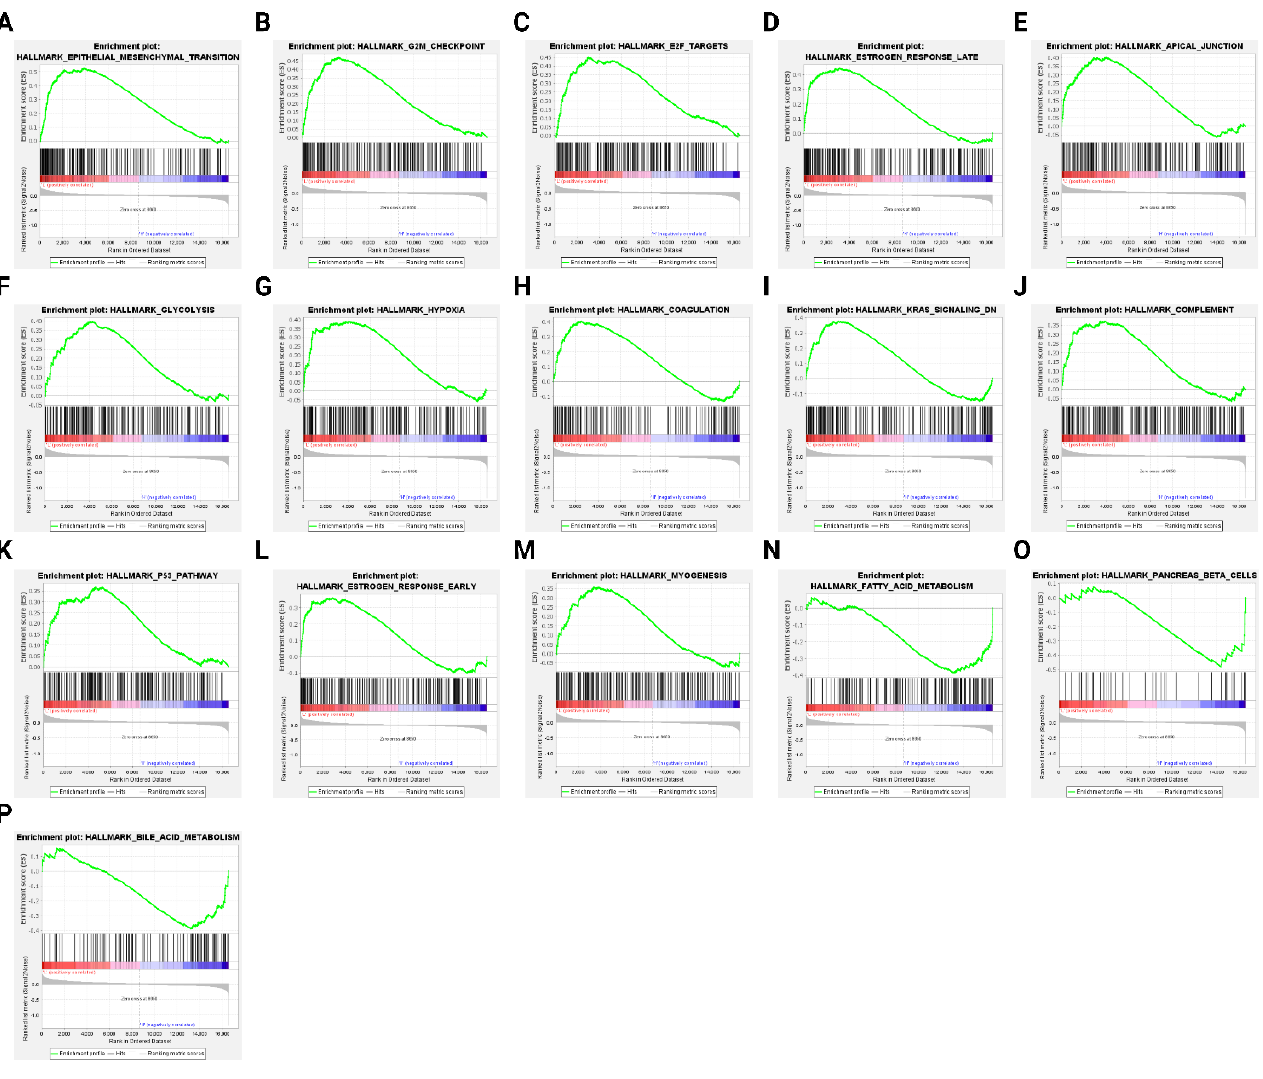
Figure 3. GSEA plots illustrating significantly enriched pathways in low ( A – M ) and high ( N – P ) ANO4 expression groups.